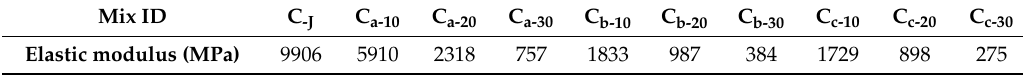
Table 6. Elastic modulus of each concrete